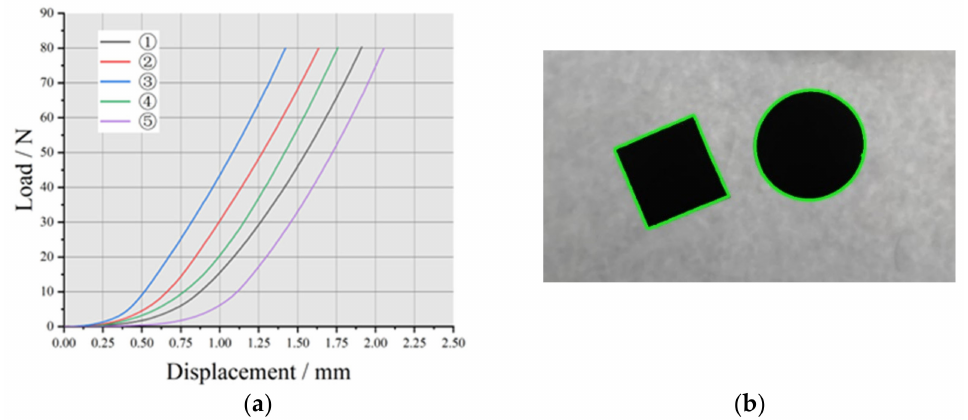
Figure 8. ( a ) The compression load-displacement curves of five NBR specimens; ( b ) the contour finding of the cross-section of the NBR specimen and the square block.